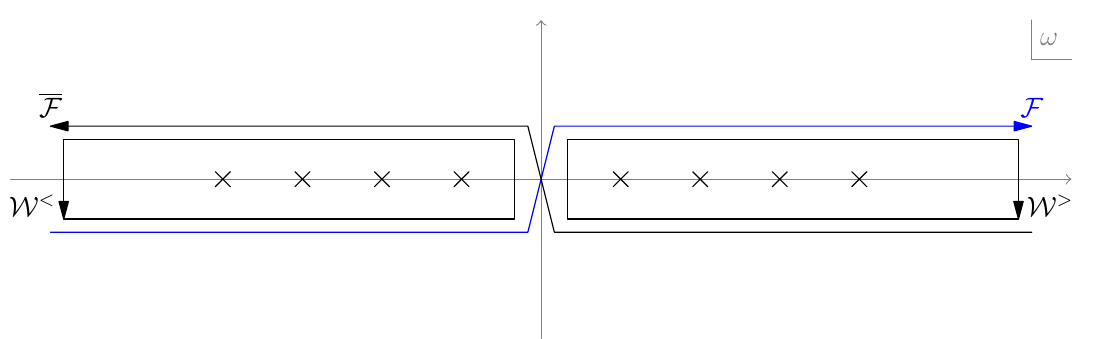
Figure 6. The contours F , F , W > , W < in the complex ω -plane. The crosses on the real line are the poles of ˜ f